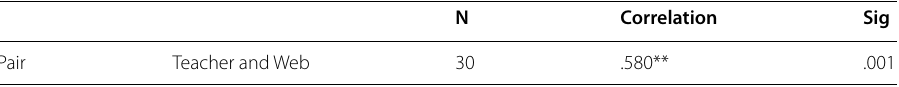
Table 5 Pearson correlations